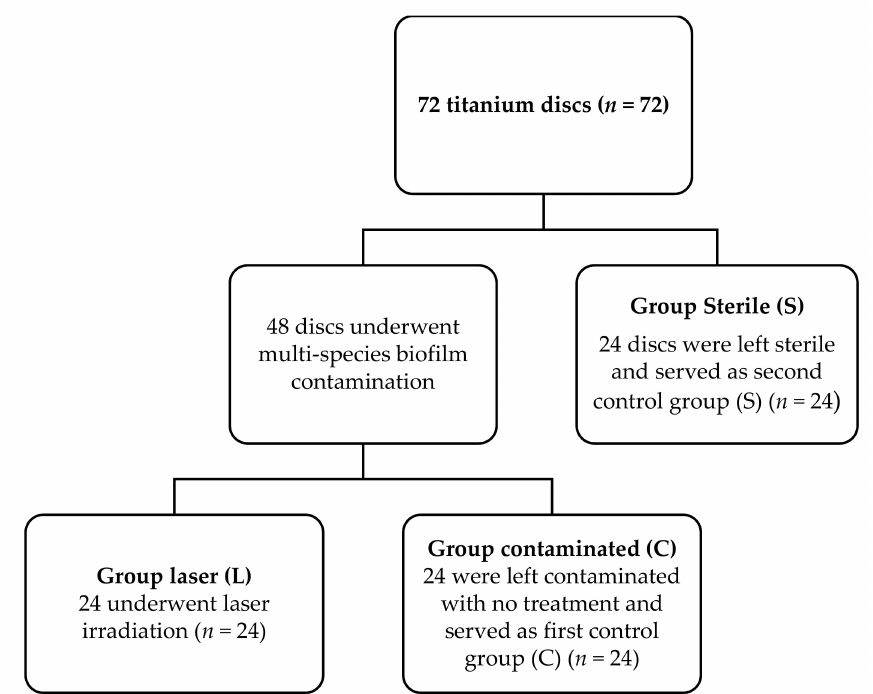
Figure 2. Design of the study. Group L is the study group consisting of contaminated titanium discs + treated with the laser; Group C is the control group consisting of contaminated discs with no treatment; Group S is the second control group consisting of sterile titanium discs with no